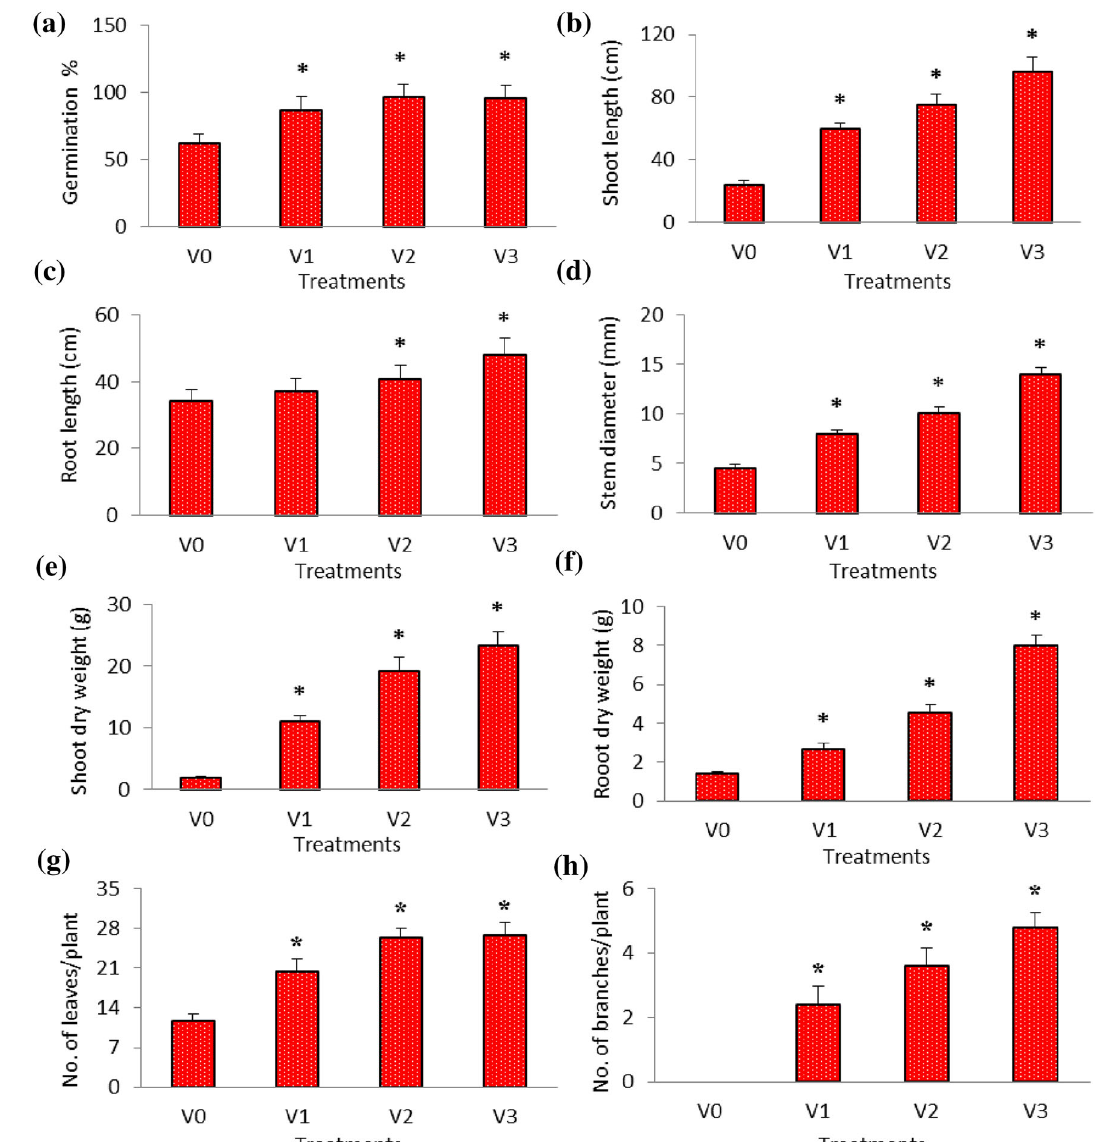
Fig. 1 Effect of salvinia vermicompost on a germination percentage; b shoot length; c root length; d stem diameter; e shoot dry weight; f root dry weight; g number of leaves; and h number of branches, of